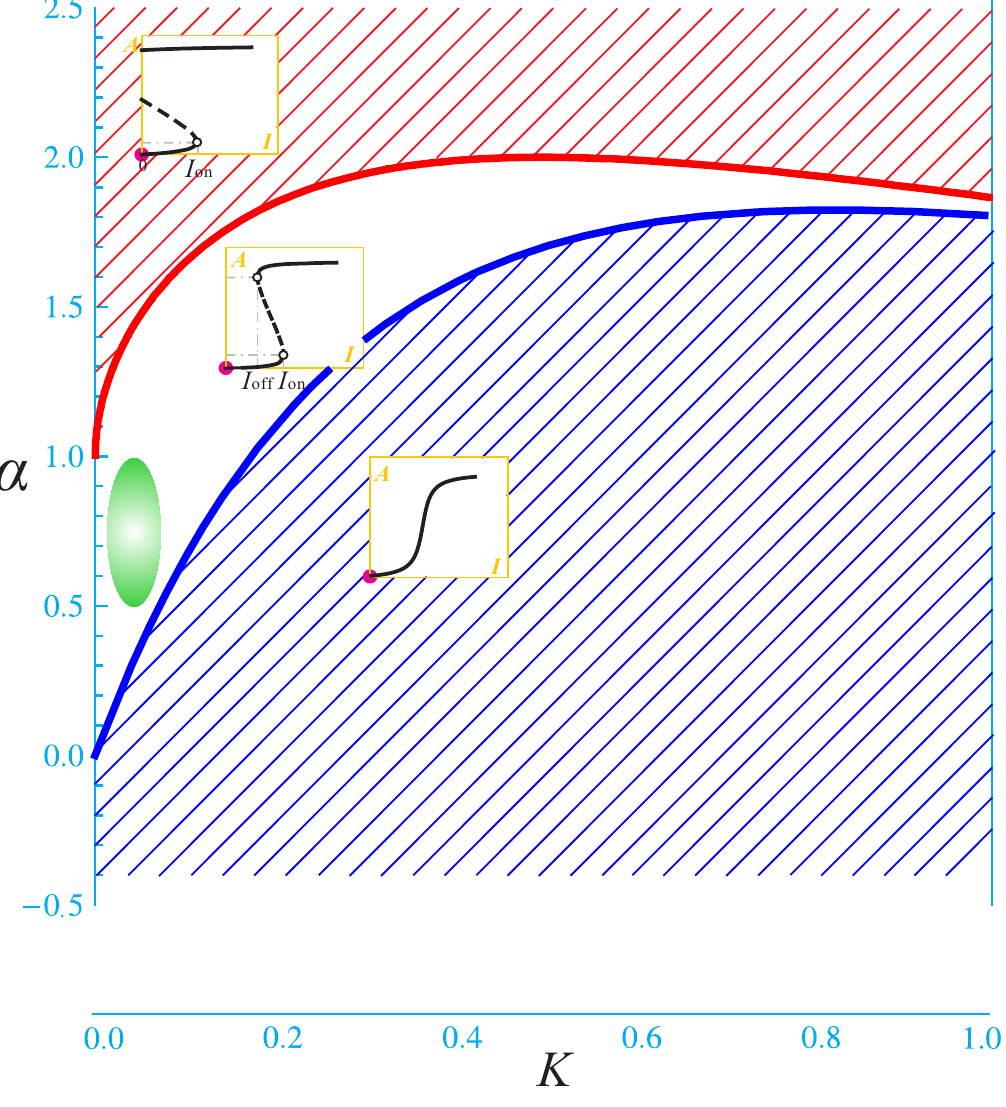
Figure 3. Parameter space of K versus α with β = 1 fixed. The space is divided into three regions, which from top down contains irreversible switches, reversible bistable switches,and graded